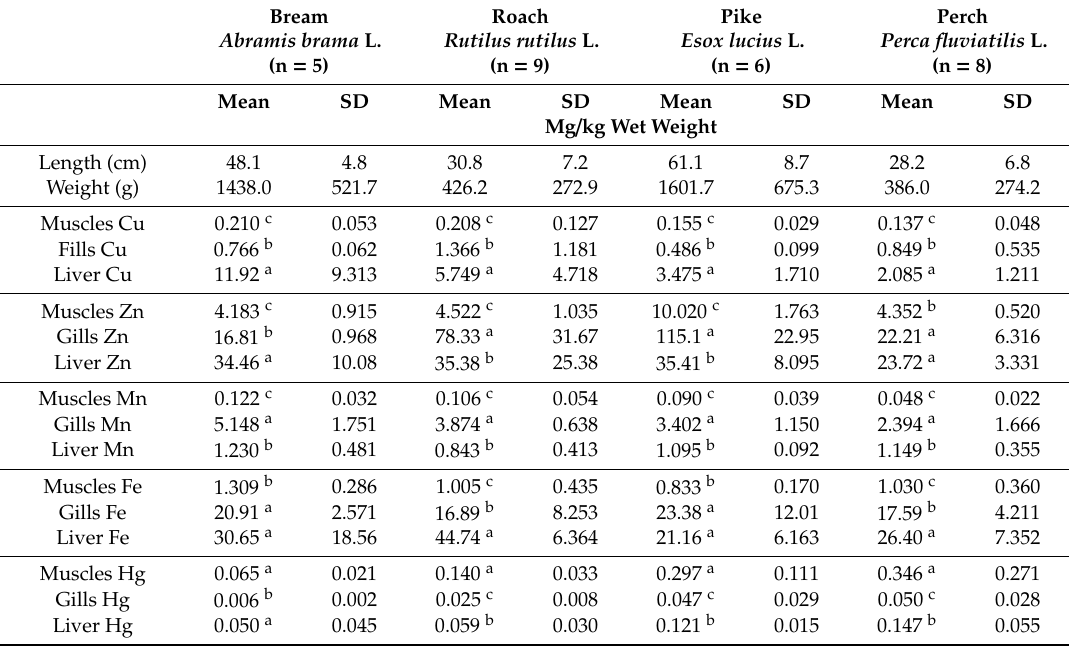
Table 1. Interspecific di ff erences (mean ± SD) in the content of heavy metals in the organs of the same fish species.